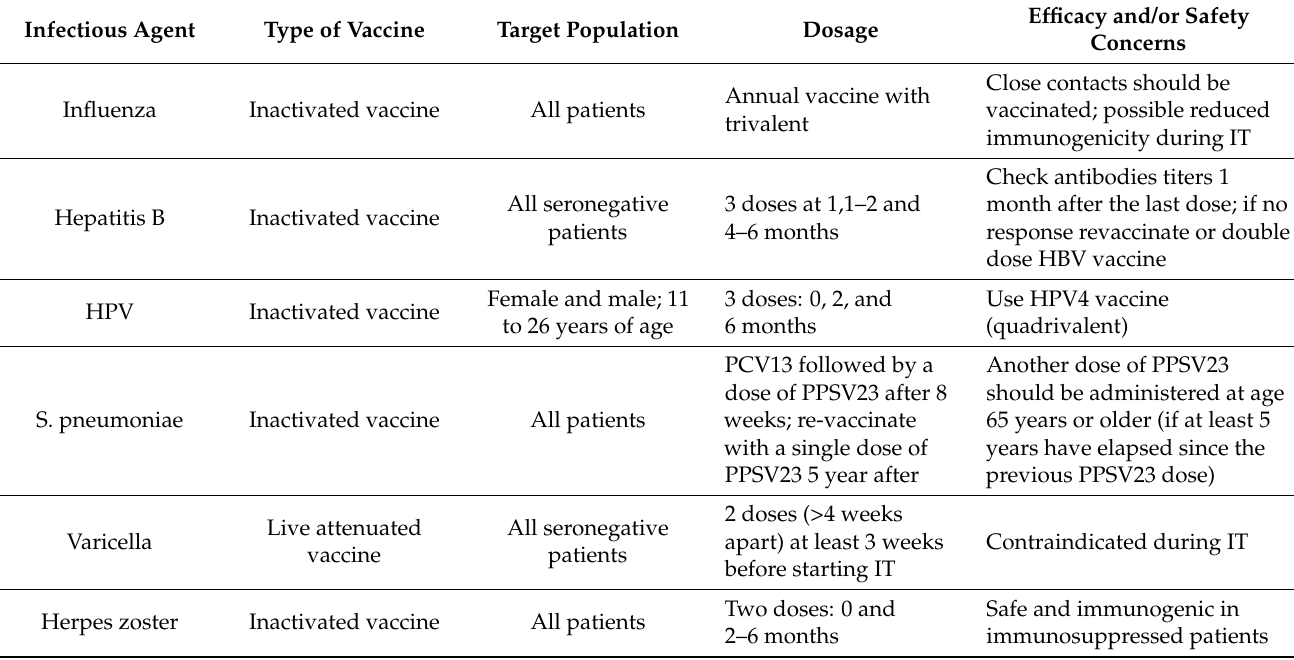
Table 1. Main vaccines recommended for patients with inflammatory bowel disease (IBD). Infectious